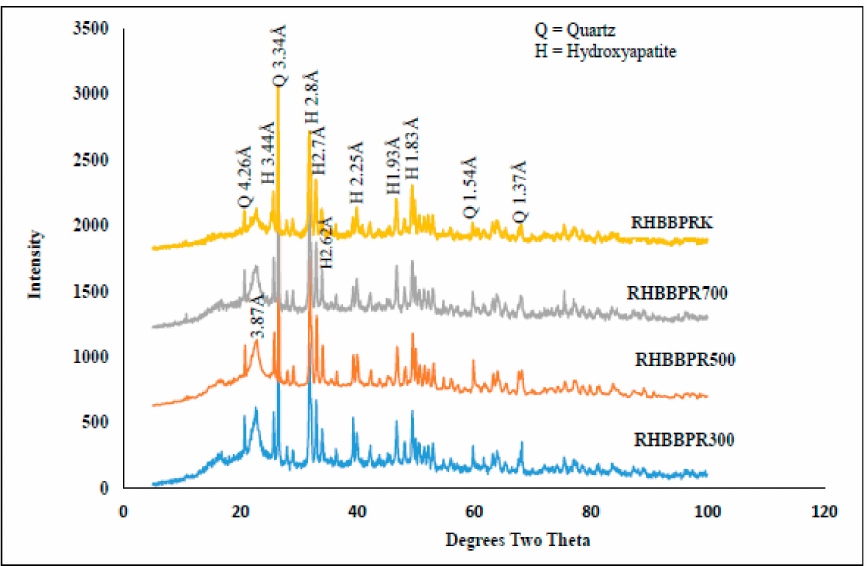
Figure 3. X-ray diffraction patterns of Burkina phosphate rock (BPR) and BPR calcinated at 300 ◦ C, 500 ◦ C, and 700 ◦